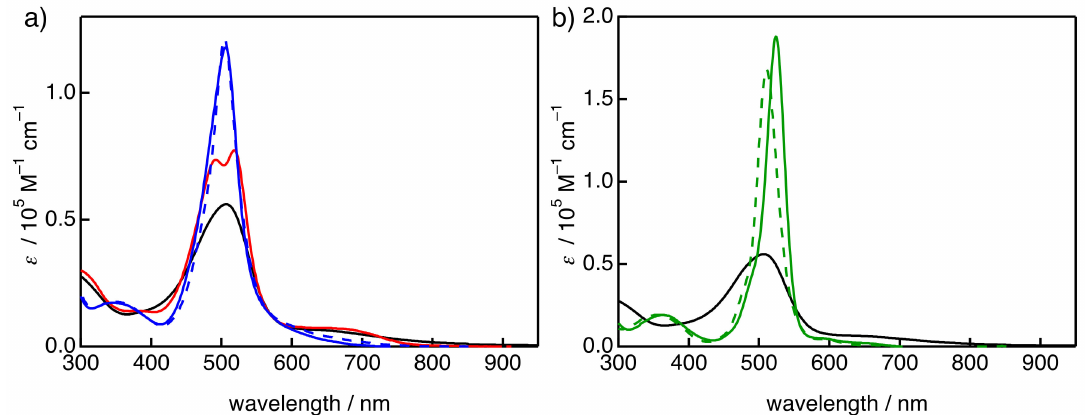
Figure 7. UV-vis absorption spectra of ( a ) Me-Hex (black), BF 2 -Me-Hex (red), 2BF 2 -Me-Hex(a) (solid blue), and 2BF 2 -Me-Hex(b) (dotted blue), and ( b ) Me-Hex (black), 3BF 2 -Me-Hex(a) (solid green), and 3BF 2 -Me-Hex(b) (dotted green) in CH 2 Cl 2